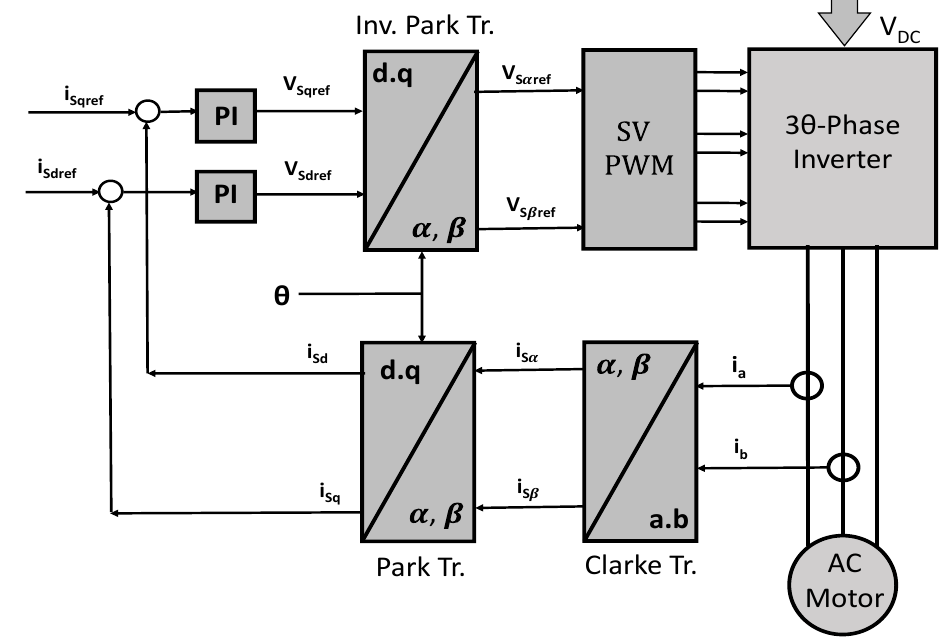
Figure 1. General sensorless indirect field oriented control (IFCO) scheme.